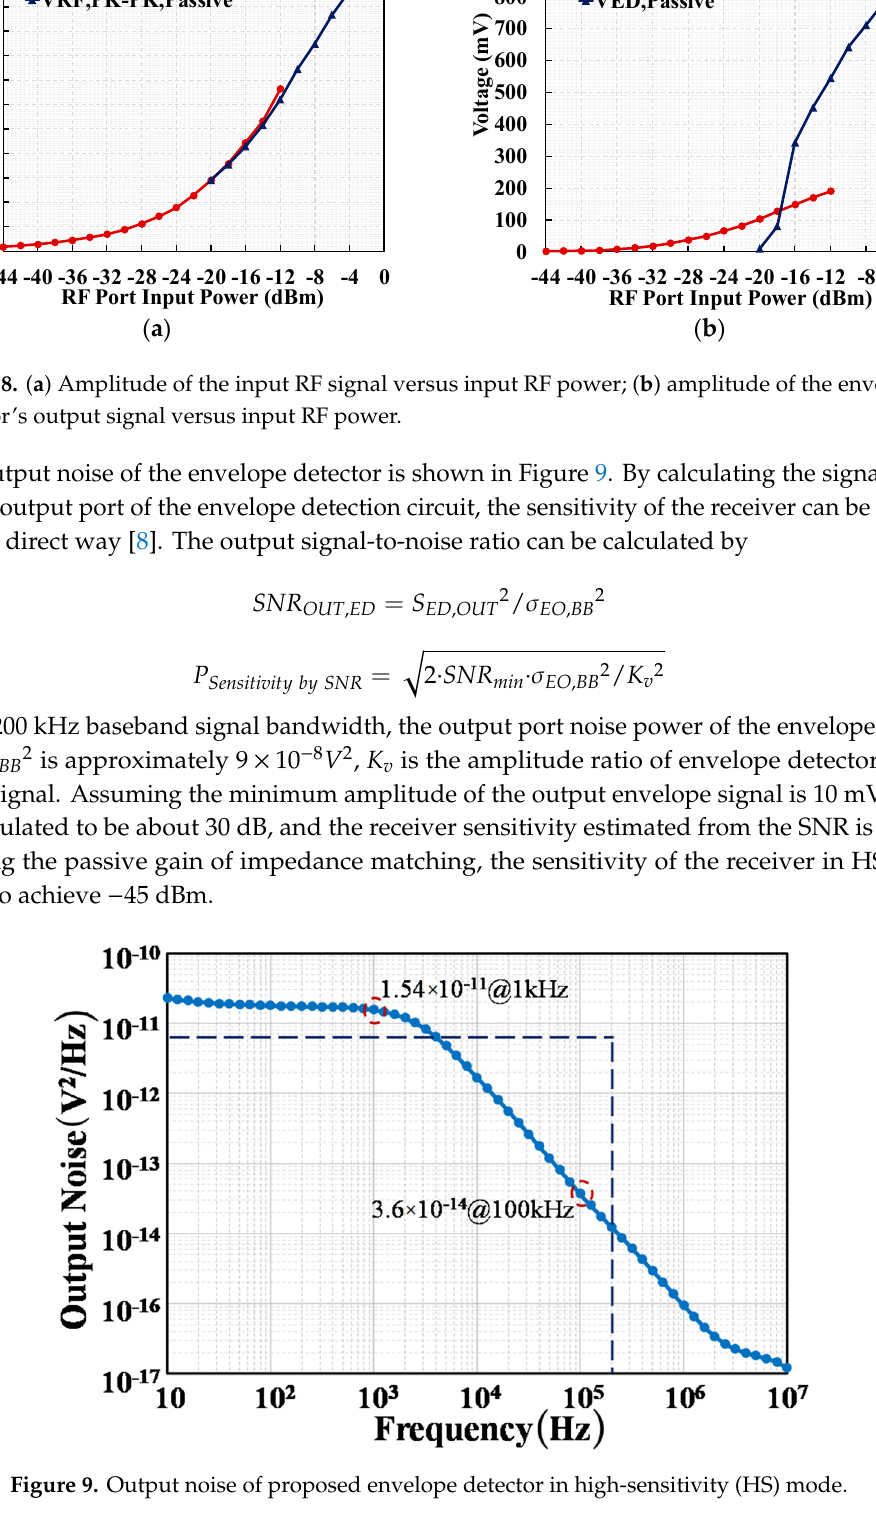
Figure 9. Output noise of proposed envelope detector in high-sensitivity (HS) mode.